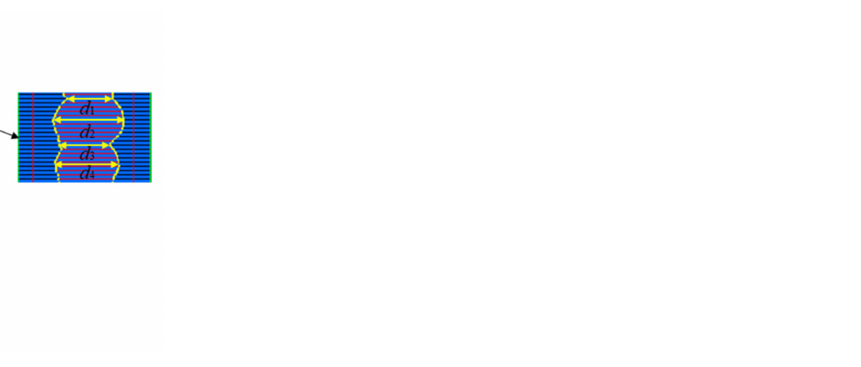
Figure 2. Schematic illustration of calculating surface roughness on the cross-section. The roughness along sample height or width was obtained from the difference between the maximum height or width of each section, as shown in Formula (4).